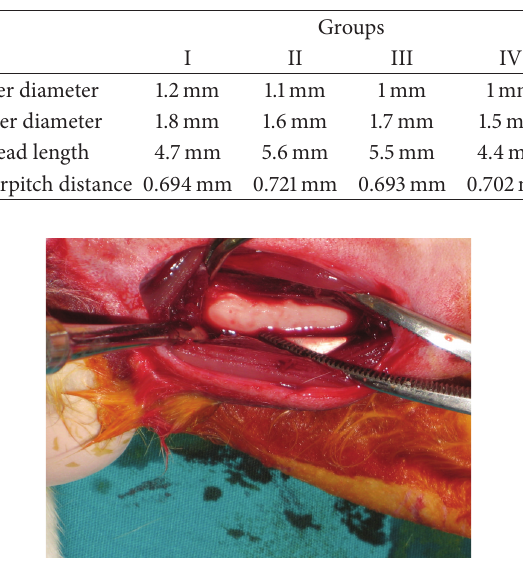
Table 1: Measurements of miniscrews by AutoDesk AutoCAD 2007.